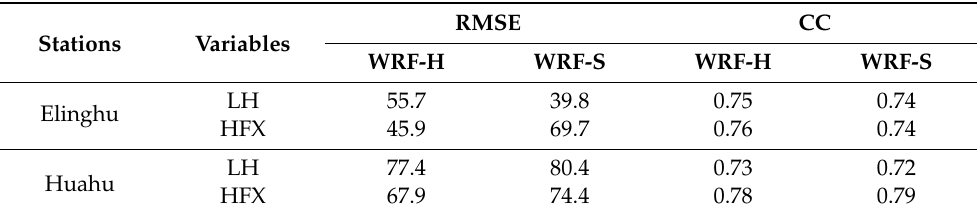
Table 4. Root-Mean-Square Error (RMSE) and correlation coefficient (CC) computed between WRF- Hydro/WRF and observation from 15 July to 30 November 2018, where the correlation coefficient passed the significance